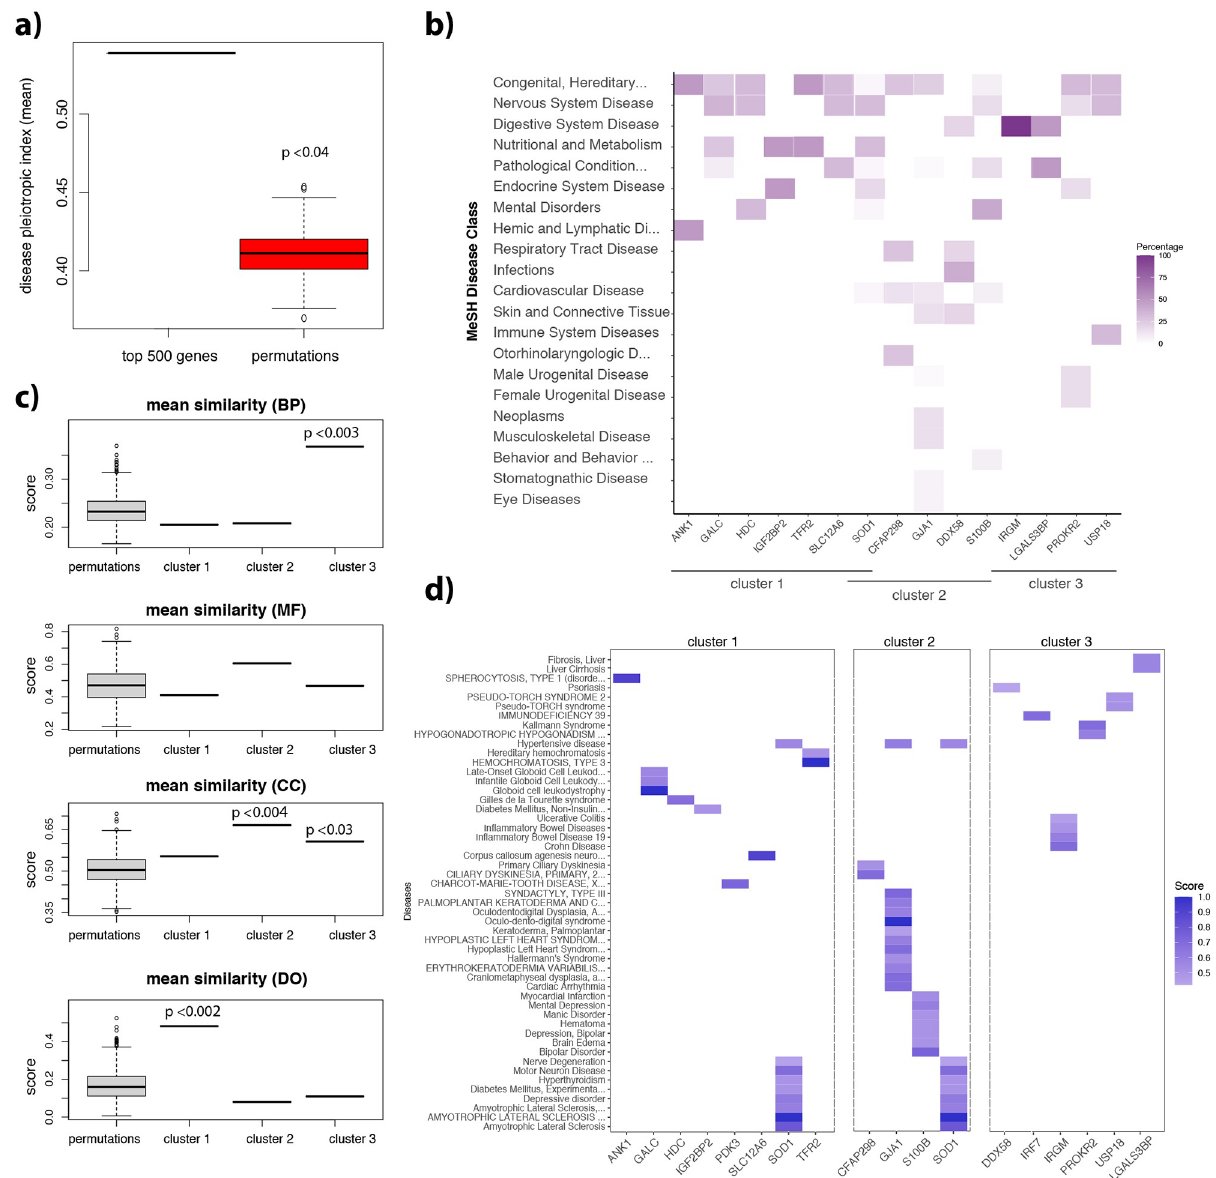
Fig 7. Disease association in DS genes. a) Boxplots comparing the mean disease pleiotropic indexes of 1000 permutation of 500 random genes compared to the mean disease pleiotropic index of the top 500 genes. b) Heatmap showing the percentage of disease classes of the genes belonging to the three clusters. Genes with high pleiotropic scores are associated with different disease classes. c) Boxplots comparing the mean similarity score of 1000 permutation of 12–13 random genes compared to the mean similarity score of the genes belonging to our three co-DE clusters. Similarity was assessed (from top to bottom panel) using the GOs biological processes (BP), molecular function (MF), cell component (CC) or disease ontology (DO). d) Heatmap showing the GDA’ scores of genes belonging to the three clusters.